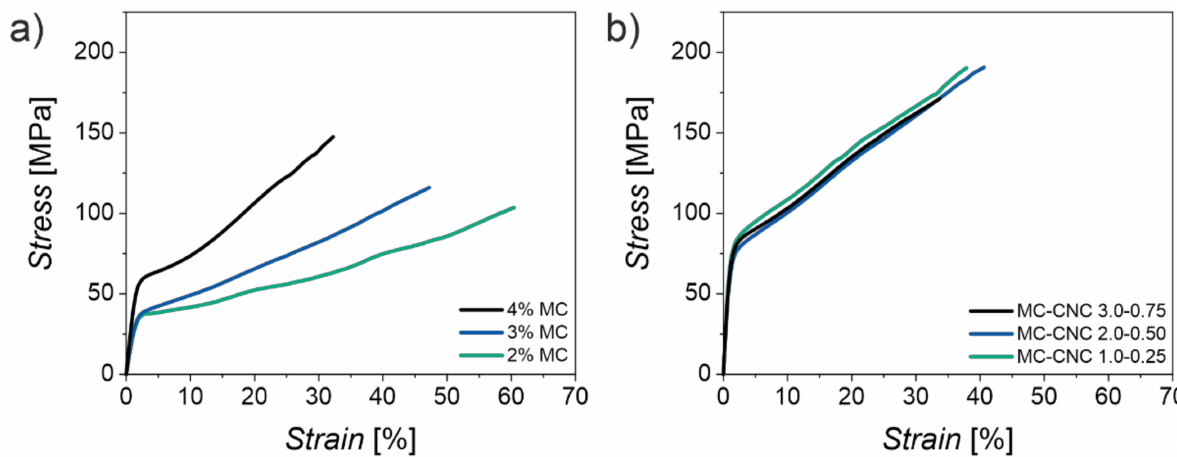
Figure 7. Mechanical properties of the MC-based fibers. ( a ) Stress–strain curves of pure MC fibers wet-spun from 2%, 3%, and 4% MC hydrogels (MW 88,000). Increased total solid content of gel appears to stiffen the resulting fibers. With low solid content, exceptional ductility above 50% is achieved. ( b ) Stress–strain curves of MC-CNC fibers with different total solid contents but with identical MC–CNC ratios (4:1). There the difference in total solid content of composite hydrogel is reflected mostly in the fiber diameter, whereas significant alterations in stiffness or ductility are not observed. Adapted with permission from [36]. Copyright 2021 John Wiley and